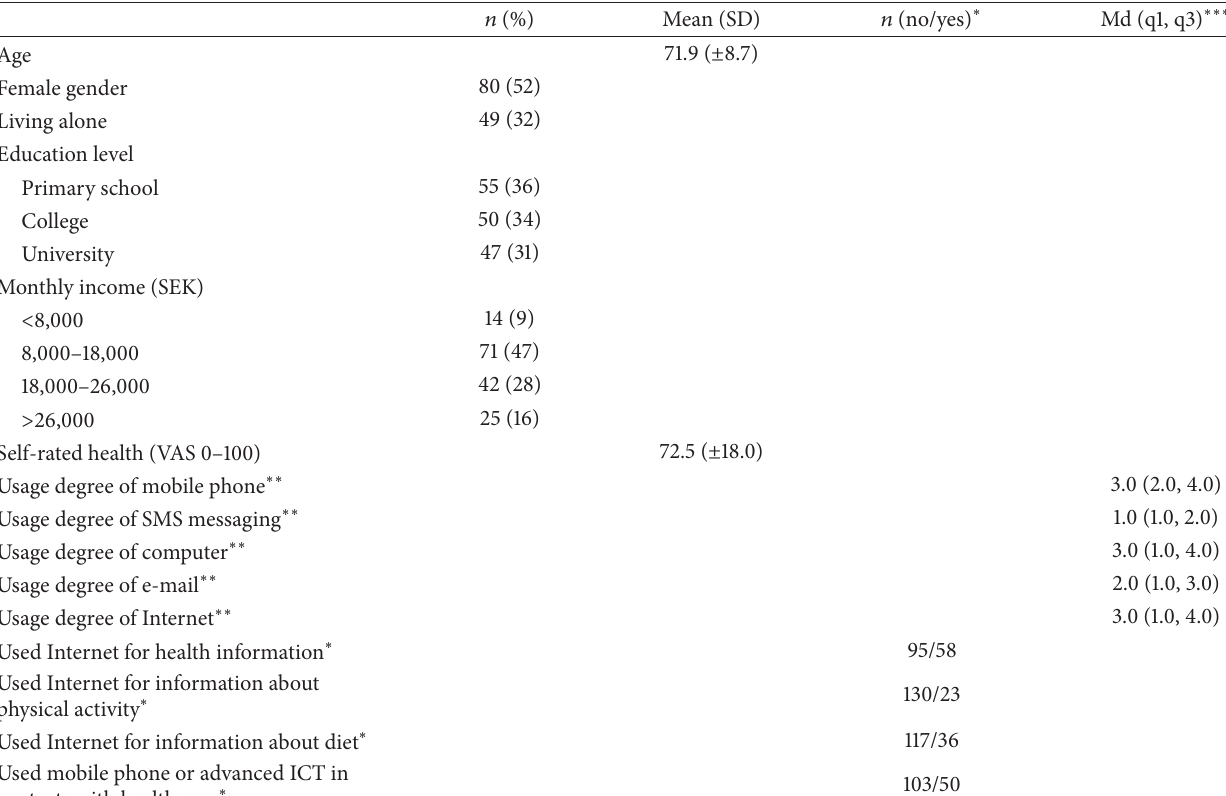
Figure 1: Flowchart of the inclusion process. Table 1: Profile of respondents (𝑛 = 154)